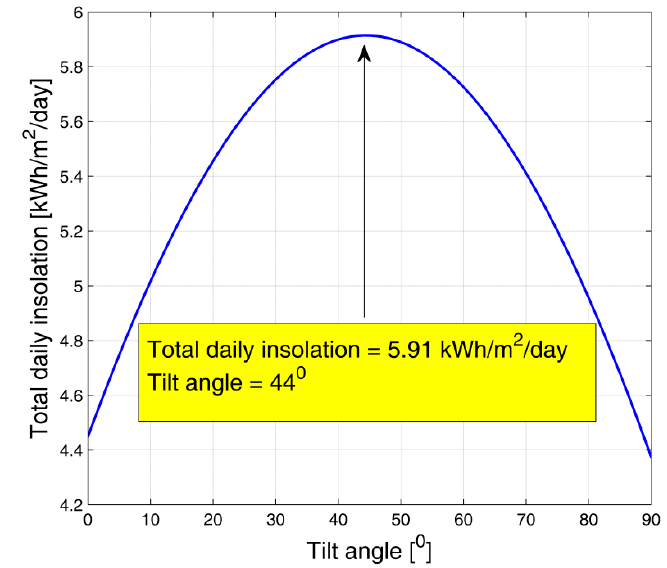
Figure 5. The calculation of an optimal tilt angle of a PV panel.